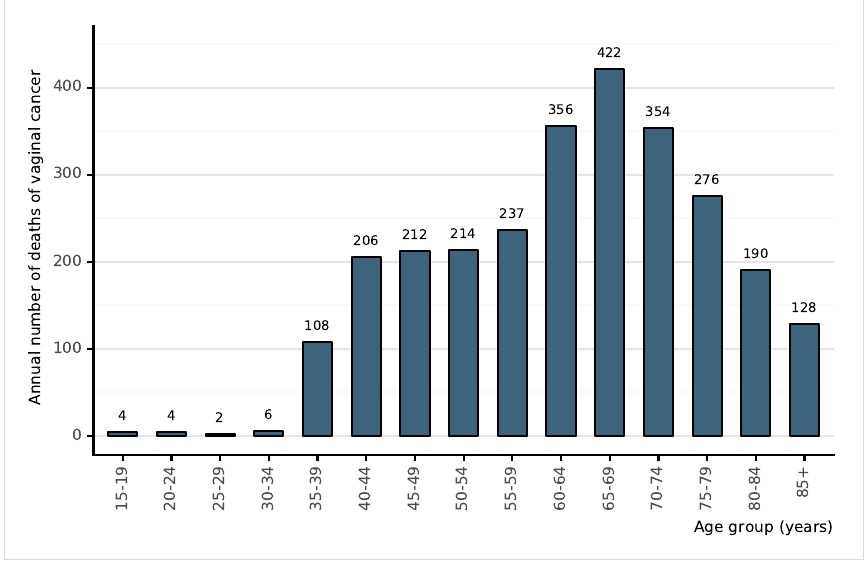
Figure 29: Annual number of deaths of vaginal cancer in India (estimates for